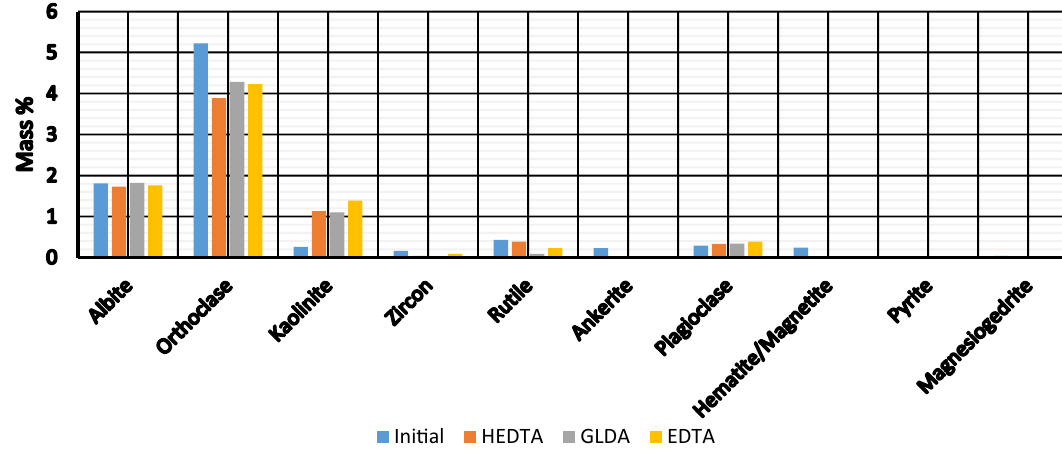
Fig. 4 Changes in mineral mass of conventional sandstone